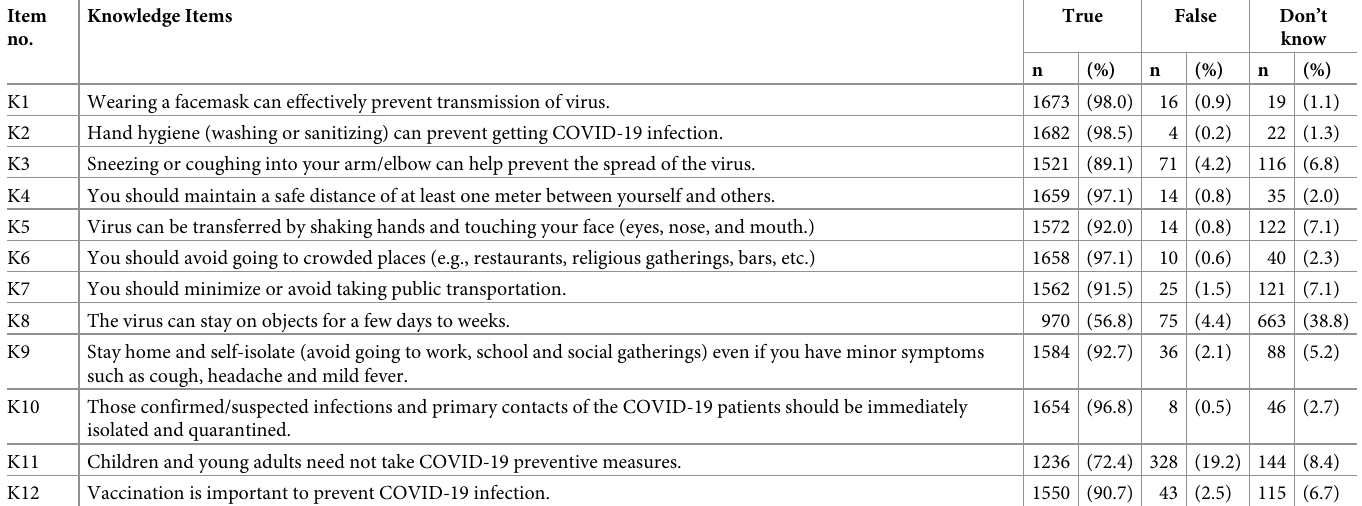
Table 2. Response to knowledge questions on COVID-19 preventive measures among participants surveyed for the knowledge, attitude and practices survey in Bhutan, January–February, 2022 (n = 1708). Item no.